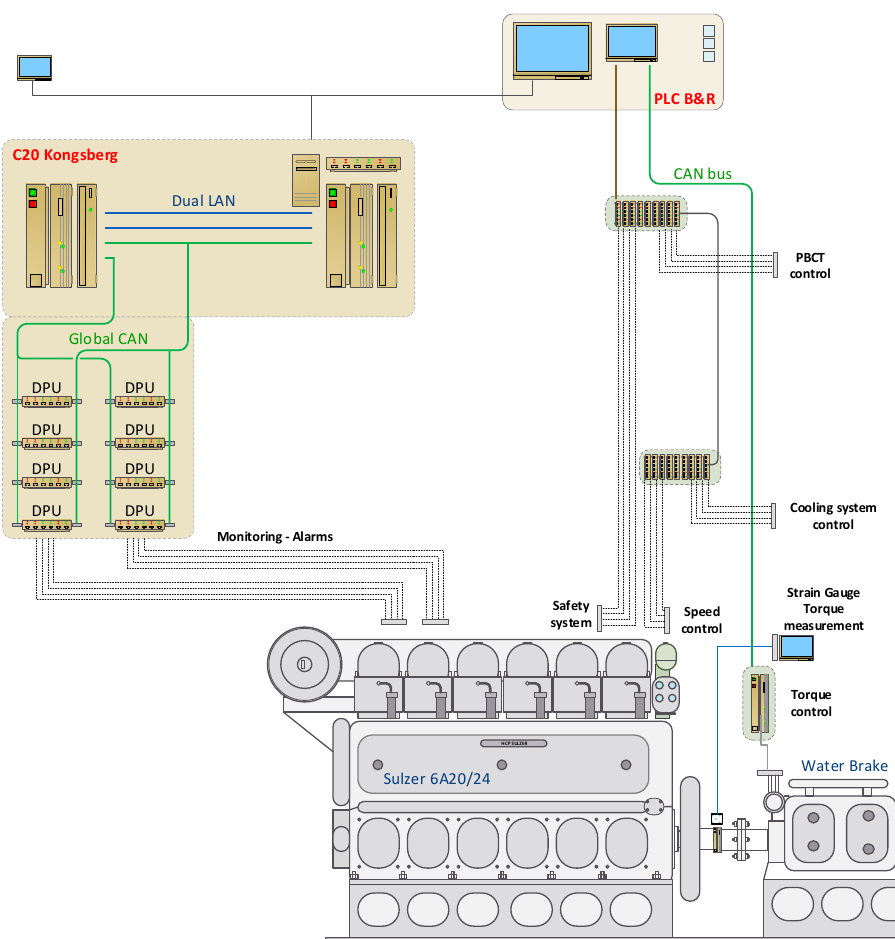
Figure 8. Engine test bed set-up